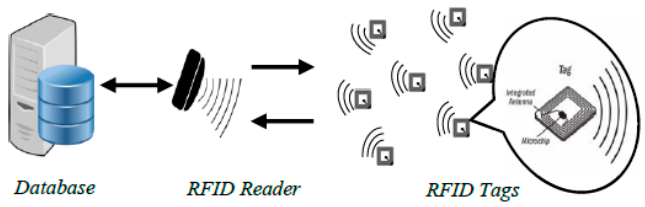
Figure 1. Basic radio frequency identification (RFID) network.